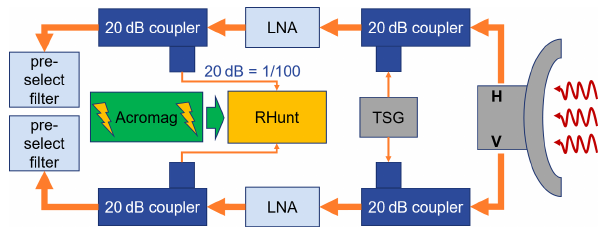
Figure 4. Diagram of the RHunt setup within the DWD radar sys- tem. The RHunt is integrated into the analogue receive path of the weather radar after the low-noise amplifier (LNA) and connected in the horizontal (H) and vertical (V) through a 20dB coupler in front of the pre-select filter. The Acromag serves as a remote-controlled power toggle. Also shown is the test signal generator (TSG), which is used to calibrate each receive